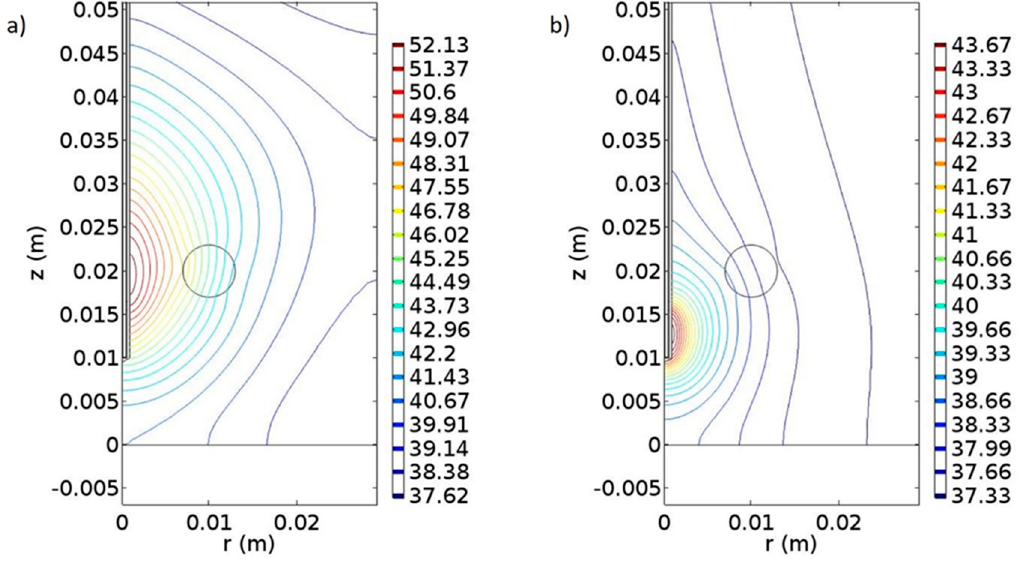
Figure 10. Simulation of microwave-induced temperature effects on prostate tissue. ( a ) Temperature distribution at the 9th min of treatment where the antenna is tuned at 2.4 GHz with power of 10 W. ( b ) Temperature distribution at the 30th min of heating where the antenna was tuned at 433 MHz with power of 30 W. The unit of the contours is in Celsius degrees, and the unit of x- and y-axes in meters. Table 1. Selected parameters for blood, dermis, epidermis, fat, tumor, and muscles tissues, as used in Equations (2)–(4).